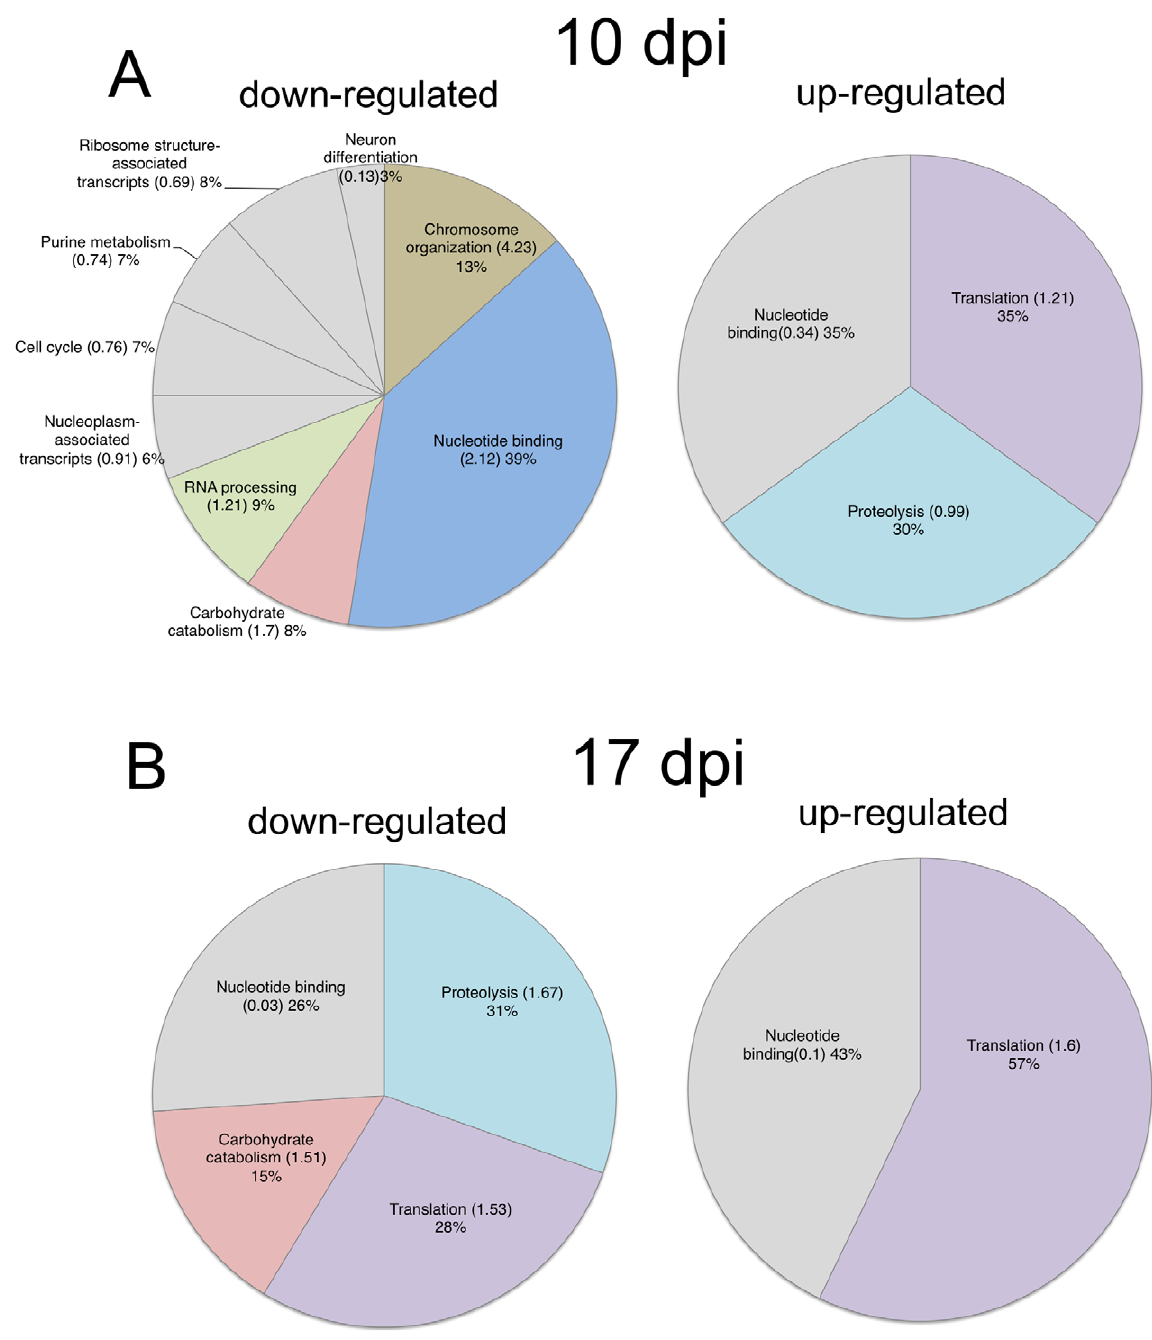
Figure 4. Results of functional annotation clustering of up- and down-regulated A.gambiae genes at 10 and 17dpi when compare with uninfected mosquitoes. Clusters with an enrichment score . 1 (value in brackets) are colored, clusters with scores , 1 are greyed out. (A) At 10 dpi, the down-regulated genes were grouped into 9 discrete clusters, with genes up-regulated in response to P. berghei infection grouped into 3 discrete clusters; (B) At 17dpi, the significantly over-represented functions of down-regulated genes are less diverse than 10dpi with carbohydrate catabolism represented at both time points. At this time point up-regulated genes make up 2 clusters.